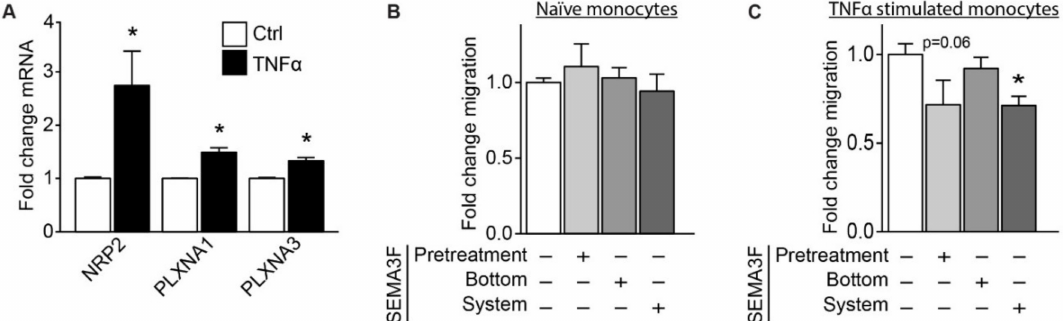
Figure 7. SEMA3F inhibits migration of TNF α stimulated monocytes. ( A ) Quantitative qPCR analysis of NRP2, PLXNA1 and PLXNA3 mRNA in THP-1 cells stimulated for 15 h with TNF α (2 ng / mL), presented relative to mRNA in unstimulated cells (control), set as 1. Mean ± SEM of n = 3, * p < 0.05. ( B , C ) Migration of THP1 cells unstimulated ( B ) or stimulated for 15 h with TNF α (2 ng / mL, C ) and with or without pretreatment with SEMA3F (500 ng / mL) or exposure to SEMA3F (500 ng / mL) in the bottom or in the whole Transwell system towards MCP1 (10 µ M). Results are presented relative to cells not exposed to SEMA3F, set as 1. Mean ± SEM of n = 3, * p <